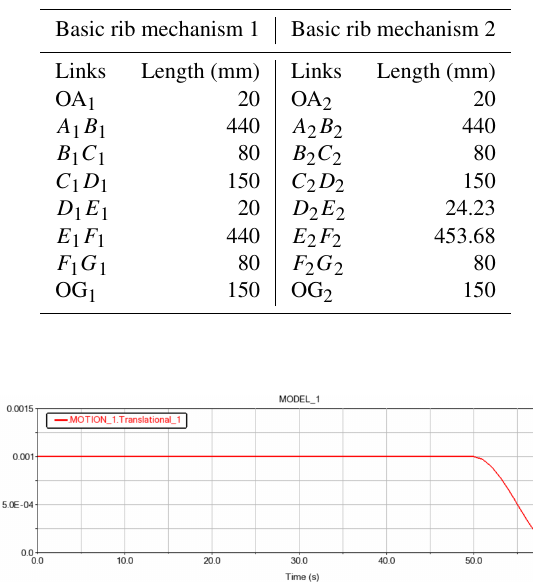
Table 1. Geometrical parameters of basic rib mechanisms.